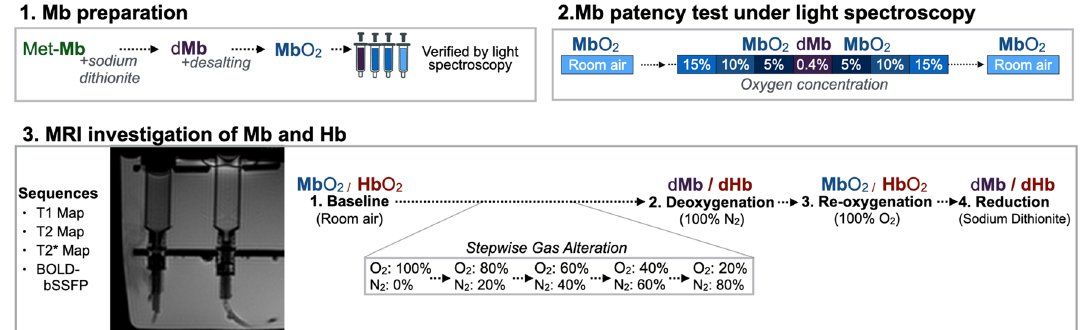
Figure 4. Experimental Procedure: (1) Equine metmyoglobin (metMb) was first reduced to deoxymyoglobin (dMb) and desalted to gain oxygenated myoglobin (MbO 2 ) by auto-oxygenation, (2) after which samples were verified with light spectroscopy during decreasing then increasing oxygen concentrations. (3) Myoglobin solution and packed red blood cells were then placed into sealed compartments designed for gas bubbling. MRI was performed with four sequences in a vertical view, and one horizontal cross-section view under conditions designed to oxygenate and de-oxygenate myoglobin (Mb) and hemoglobin (Hb).